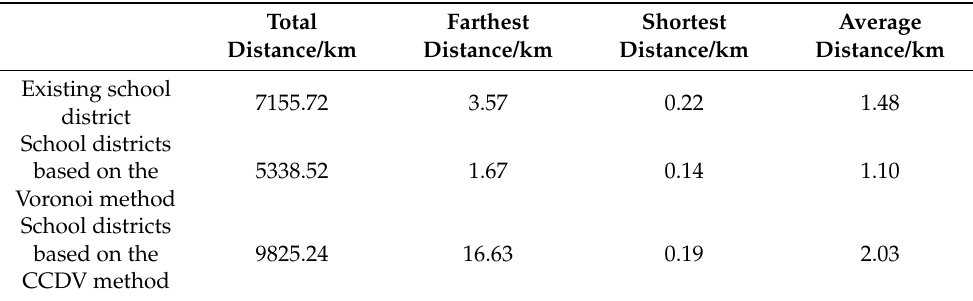
Table 1. Comparison of the distance to school for students in the school district based on different